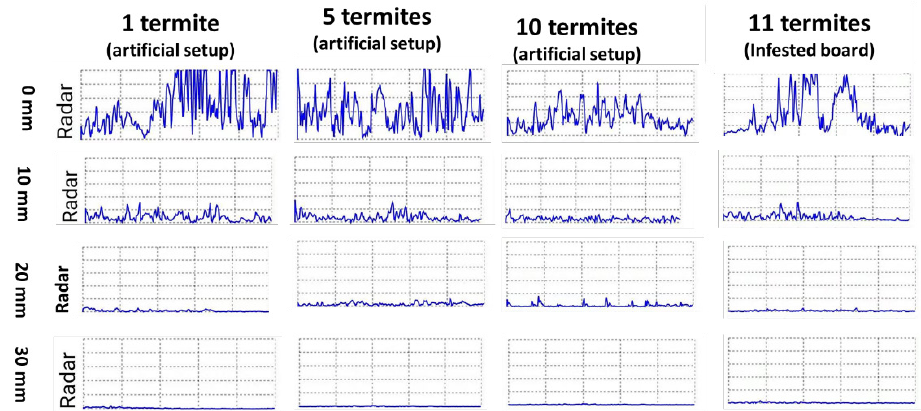
Fig 2 . Examples of Termatrac™ output as affected by the number of termites and their depth in the wood . Lines above the baseline denote termite movement (i.e. detection). Note the decline in signal with increasing depth with a given number of termites but no signal change with increasing termite numbers.